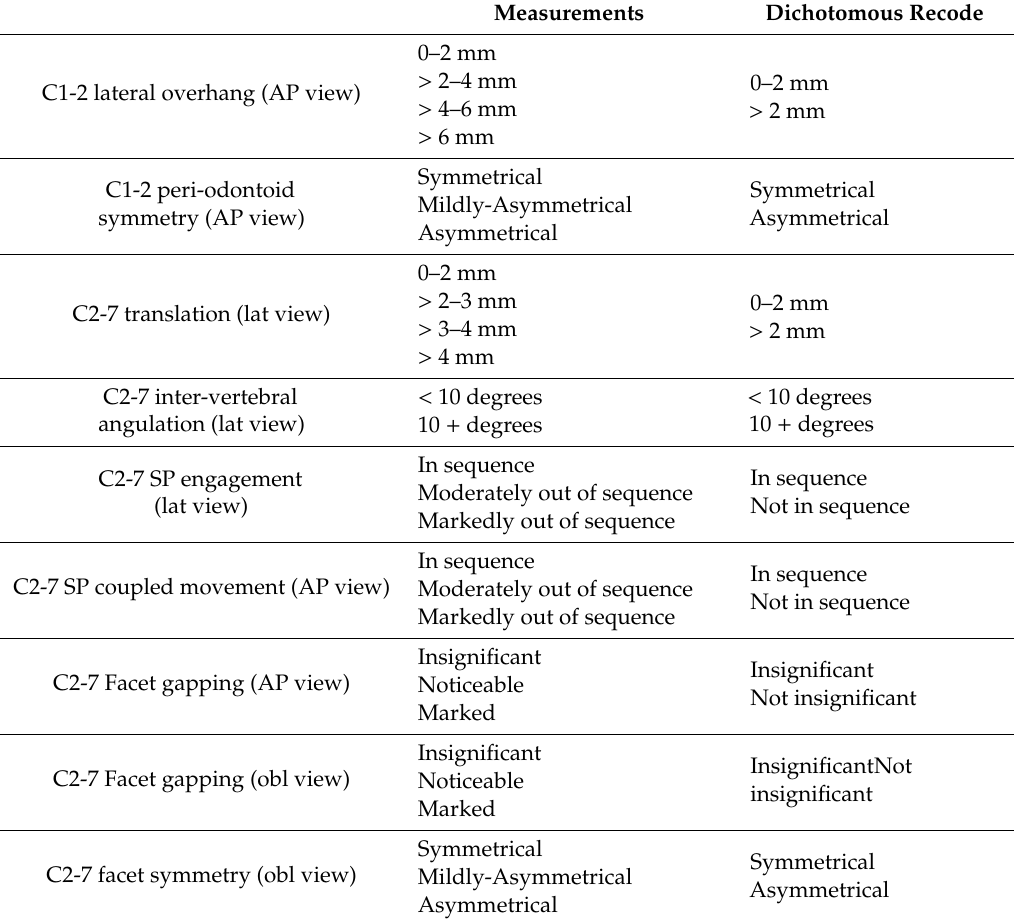
Table 2. Definitions used for each VF parameter measurement.